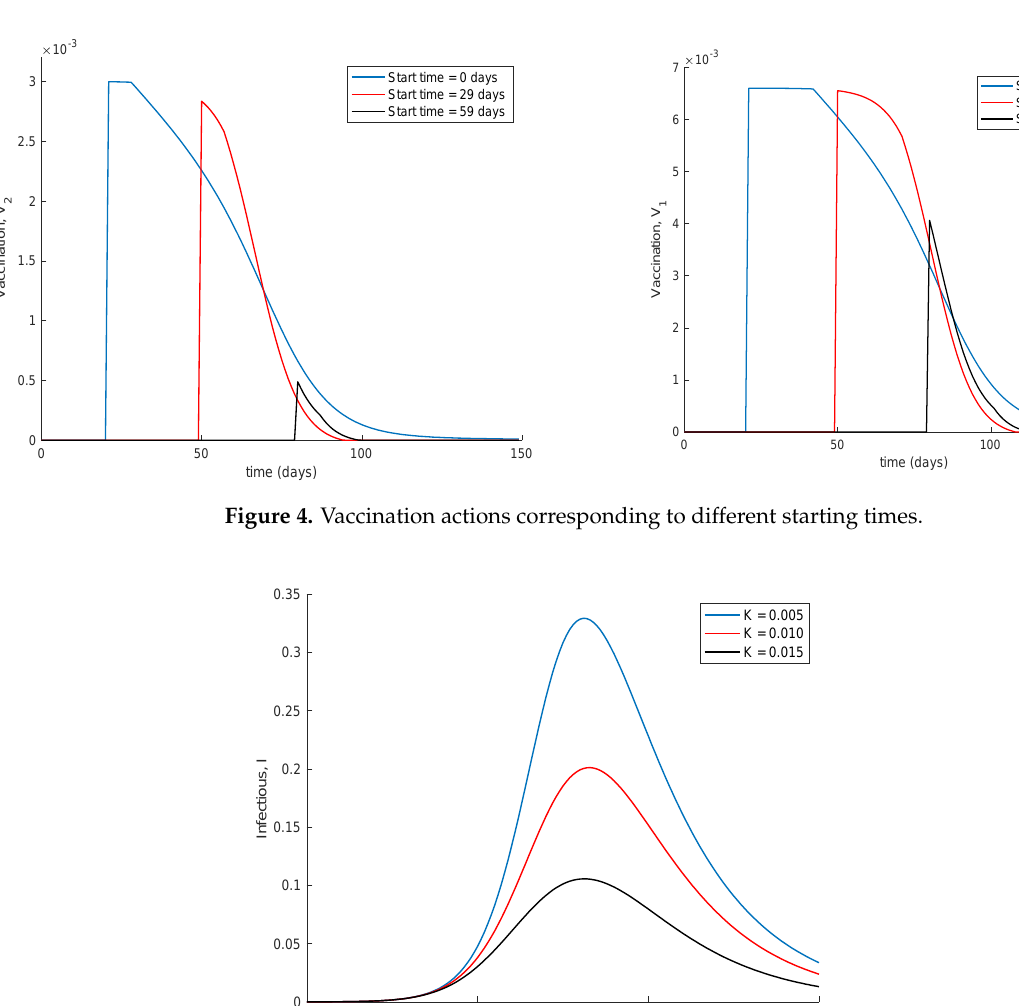
Figure 3. Effect of vaccination starting time on the infectious.